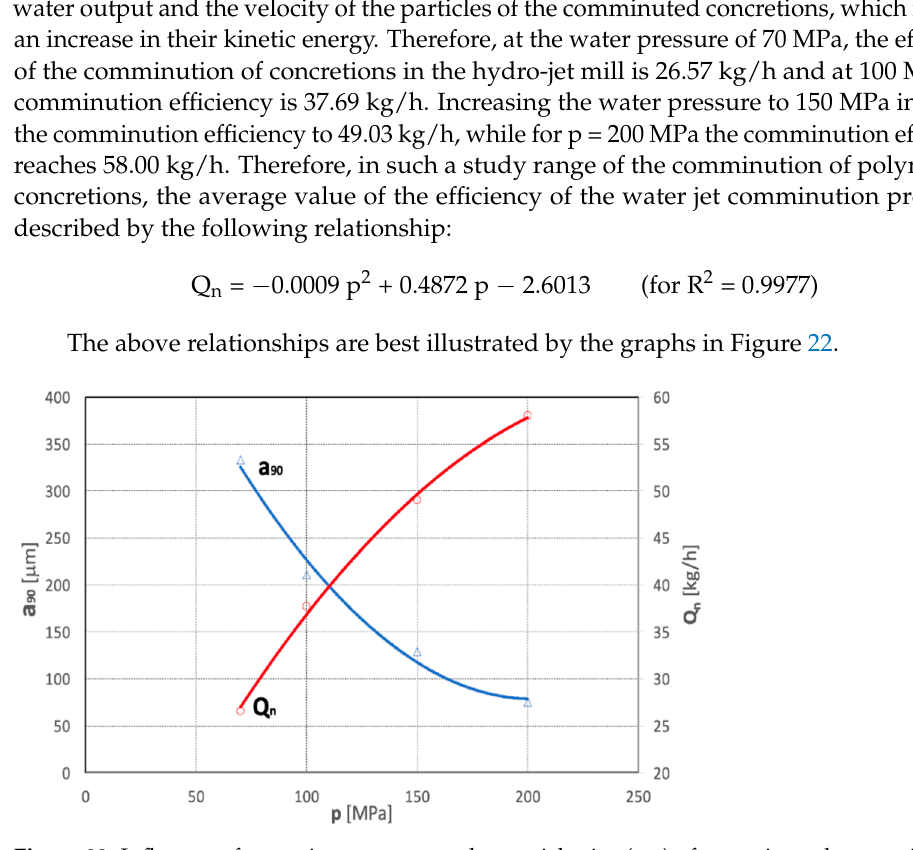
Figure 22. Influence of water jet pressure on the particle size (a 90 ) of comminuted concretions and efficiency (Q n ) of their water jet comminution process (for d w = 0.7 mm, d h = 2.4 mm, s = 10 mm).